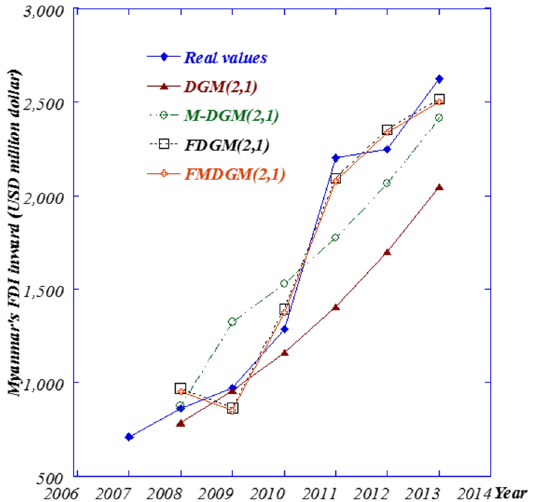
Figure 2. Comparison of the forecasting capability of different DGM(2,1) models for Myanmar’s inbound FDI.